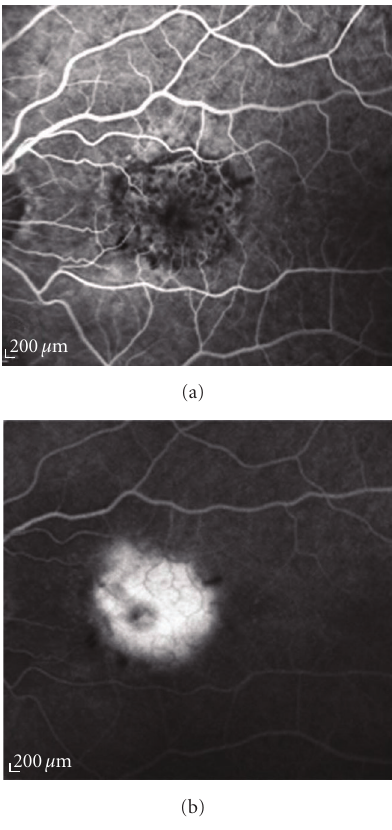
Figure 2: Fluorescein angiography of a predominantly classic choroidal neovascularization. (a) Early and (b) late angiograms: the lesion has a mixture of angiographic features of the classic and occult type, with the classic component making up more than 50% of the entire neovascular